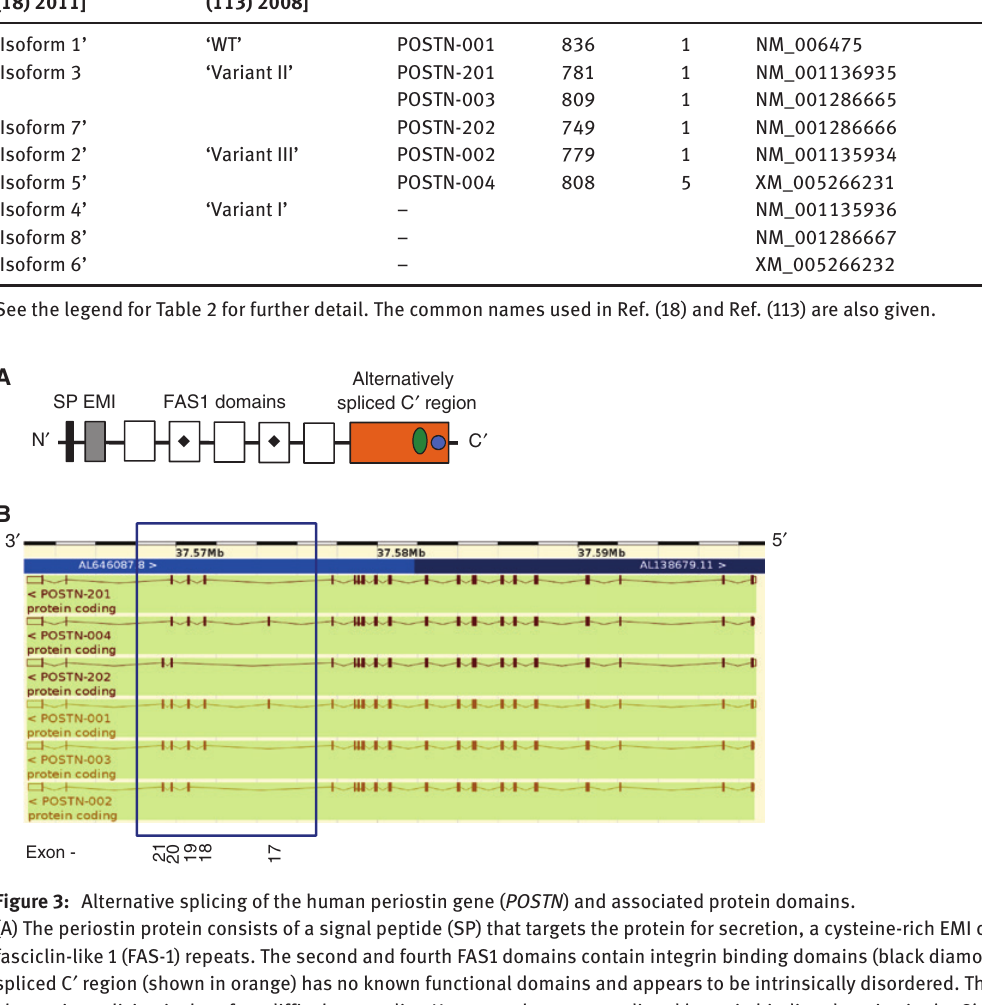
Table 4: Periostin splice variants encoded by the POSTN gene. Common